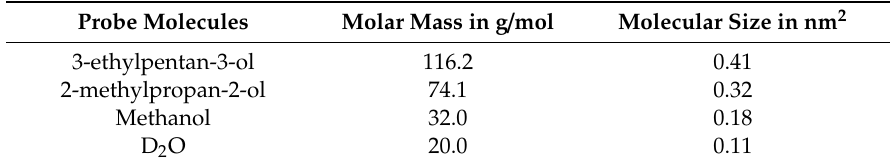
Table 6. Four reactants used for the hydrogen–deuterium (H–D) exchange including their molar mass and molecular size [34].